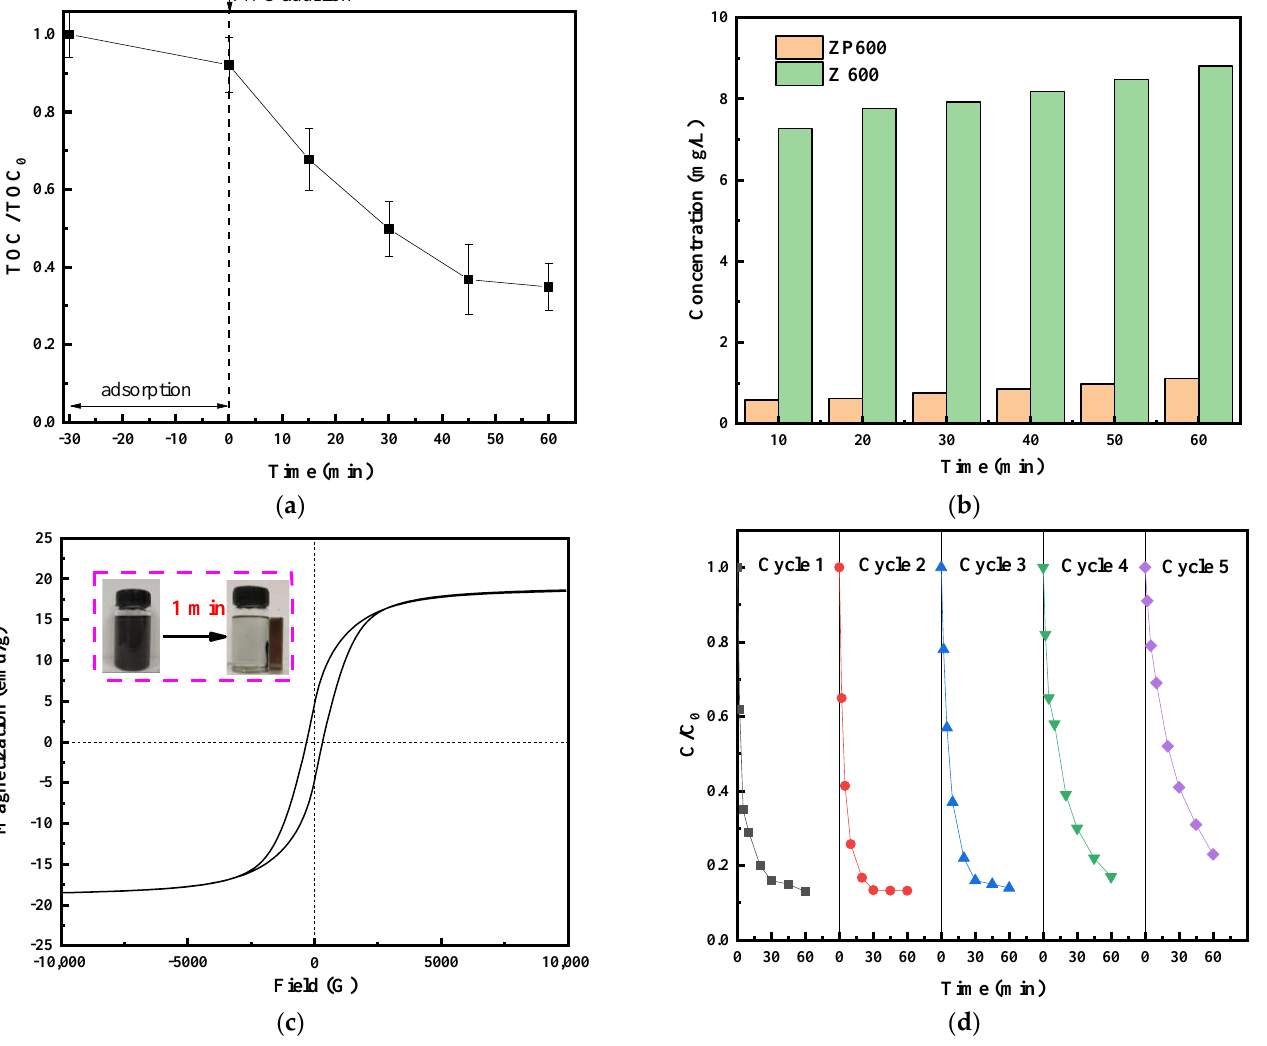
Figure 9. ( a ) Removal efficiency of TOC in the ZP600/PMS/DMP system; ( b ) Leaching of cobalt ions in the degradation process; ( c ) Magnetic hysteresis loops of ZP600; ( d ) Removal efficiency of DMP in multiple uses of ZP600. Reaction conditions: initial solution pH = 8.5, catalyst = 0.1 g/L, PMS = 0.5 mM, and DMP = 6 ppm.